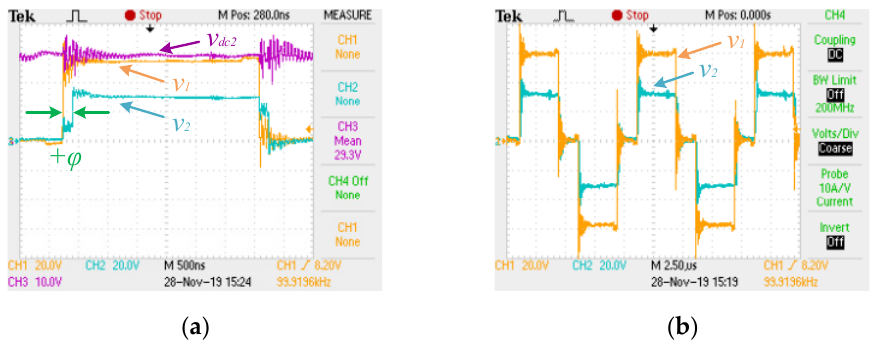
Figure 11. G2B operation mode, comparing the phase shift angle ( φ ) between v 1 and v 2 during unbalanced and balanced conditions applying a DPS modulation: ( a ) during a half-cycle on an unbalanced situation—voltage on the primary (CH1: 20 V/div) and secondary (CH2: 20 V/div) side of the high-frequency transformer and on the secondary dc-link (CH3: 10 V/div); ( b ) on a balanced